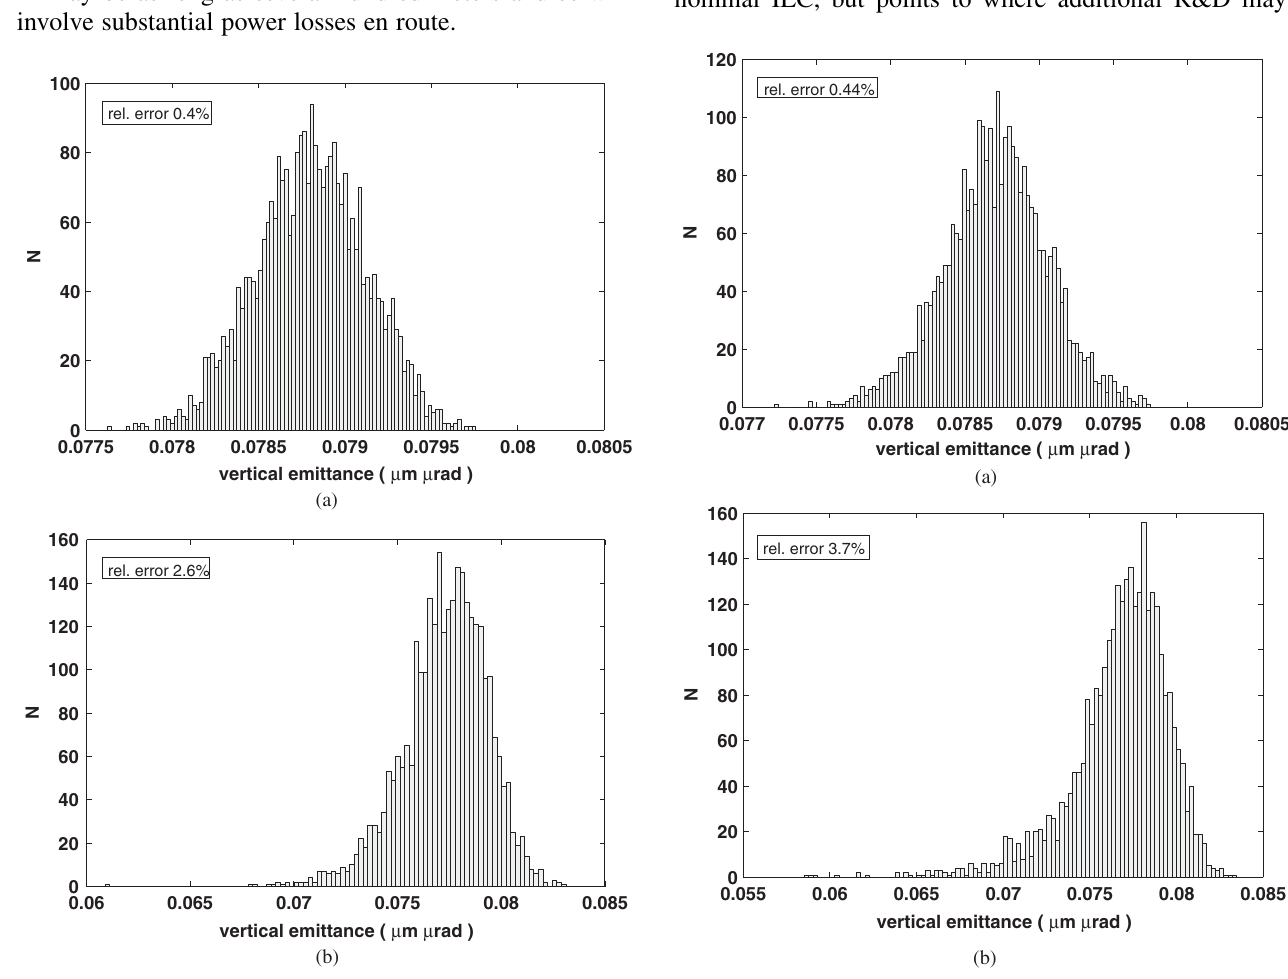
FIG. 17. Distribution of reconstructed vertical emittance with 1% (a) and 5% (b) random errors on the beam size measurement for a 4D diagnostics section (statistics corresponding to train length). Initial optical functions are perfectly matched. The true emittance is 0 : 079 (cid:3) m (cid:8) (cid:3) rad .